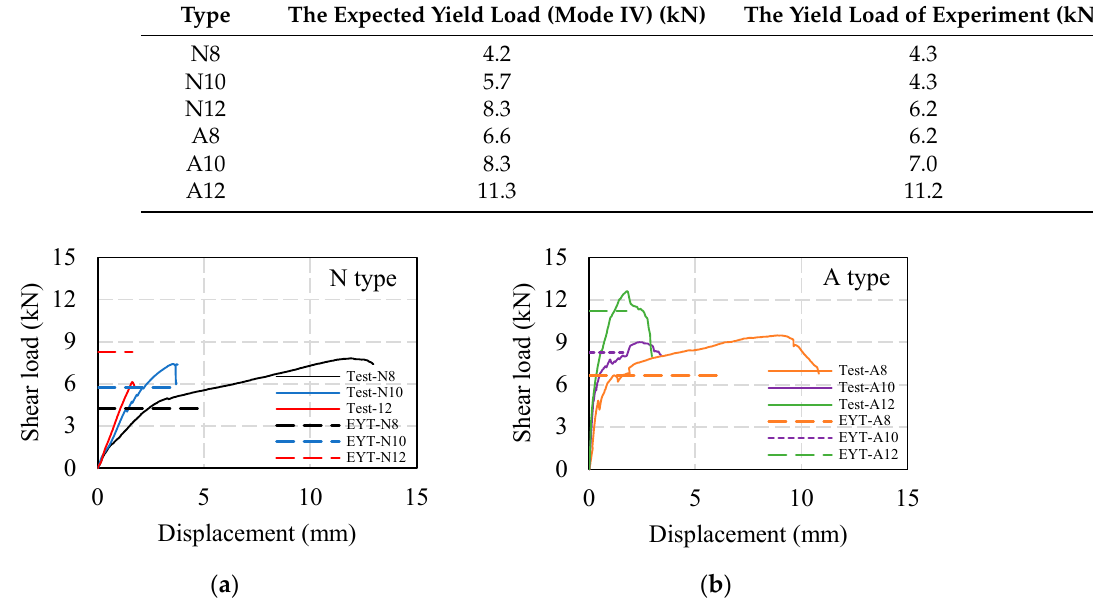
Figure 16. The load-displacement diagram of the shear test. ( a ) N-type; ( b ) A-type.